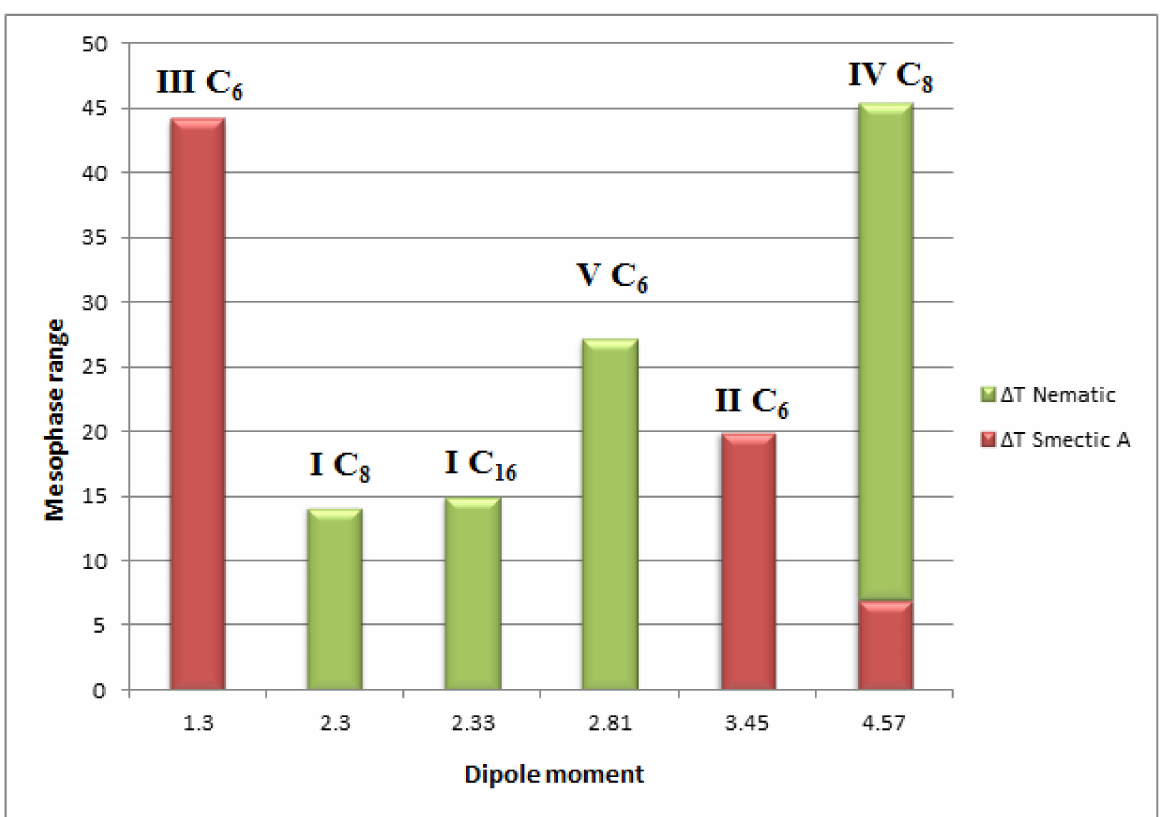
Figure 11. Graph of total mesophase range (nematic and smectic A mesophase) versus dipole moment of compounds I C 8 , I C 16 , II C 6 , III C 6 , IV C 8 , and V C 6